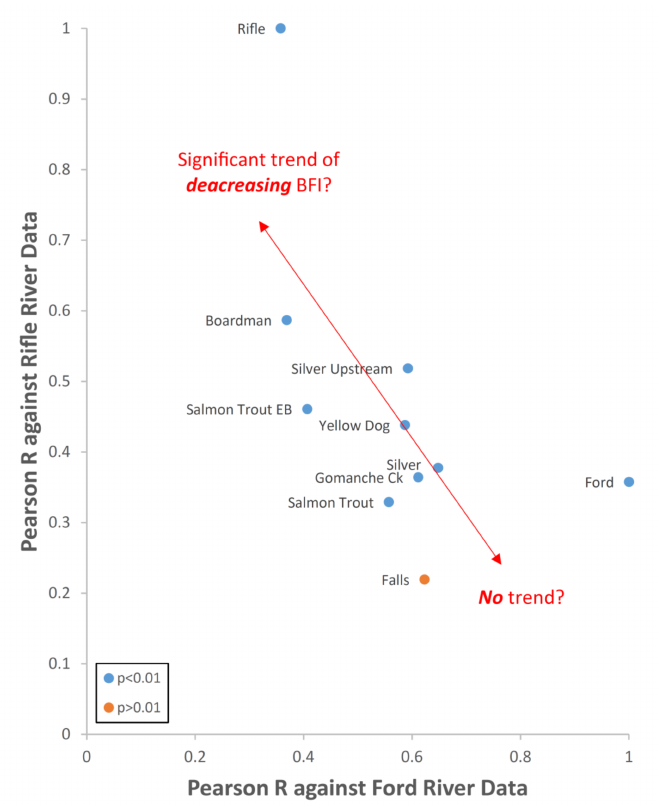
Figure 8. Pearson R correlation coefficients for concurrent monthly BFI of stream sites against long- term monitoring sites. Samples plotting close to the Rifle River end-member could be affected by a similar long-term trend of increasing baseflow and decreasing